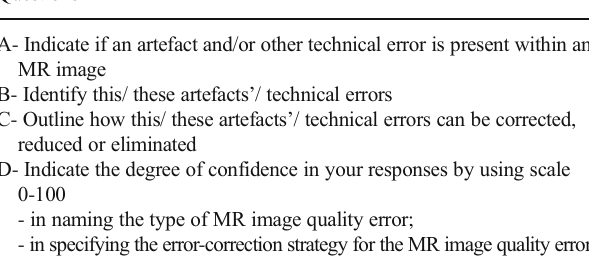
participated (Table 2). The MR images ( n = 25) reviewed by